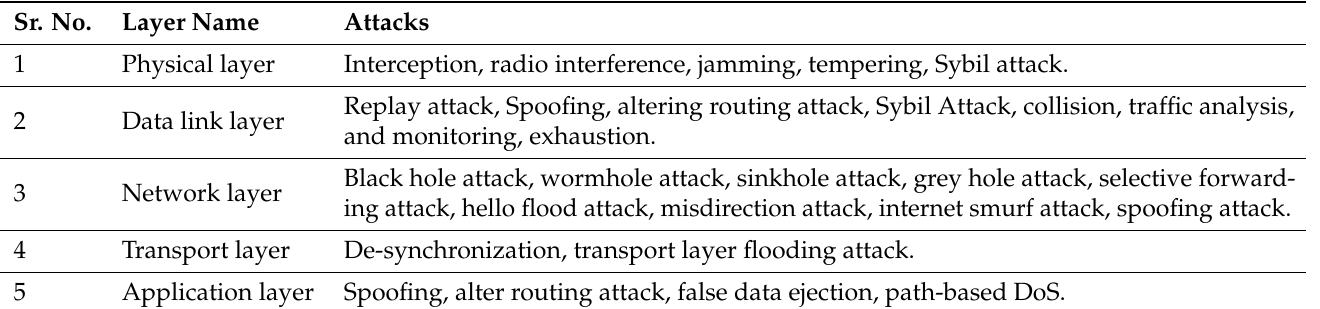
Table 8. Network Security Attacks on IoT and WSN